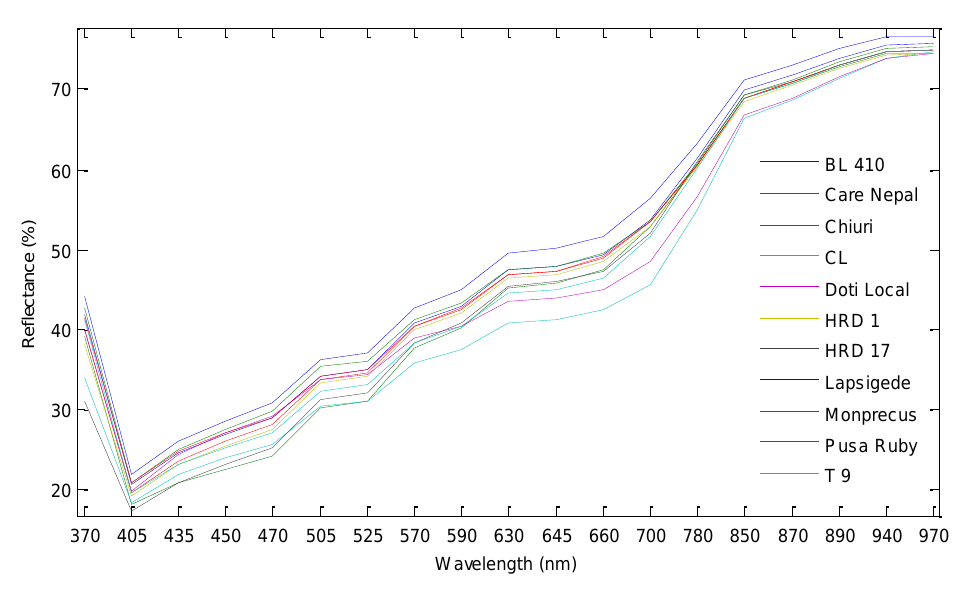
Figure 5. Mean spectrum of eleven